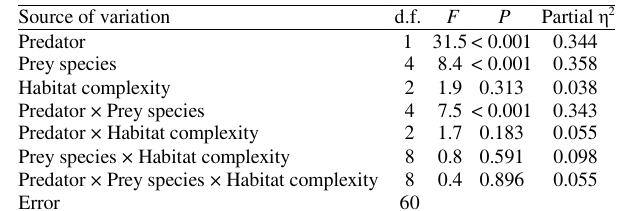
Table 1. Effects of predator presence ( P. corruscans ) and habitat complexity on prey survival (arcsin-transformed data): between-subjects factors (Huynh-Feldt corrections) of repeated-measures analysis of